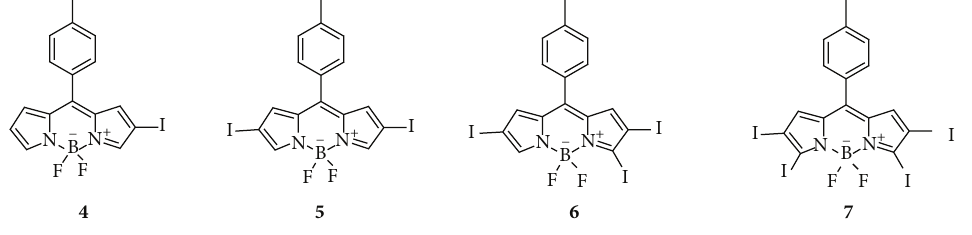
Figure 5: Structures of BODIPY 4 – 7